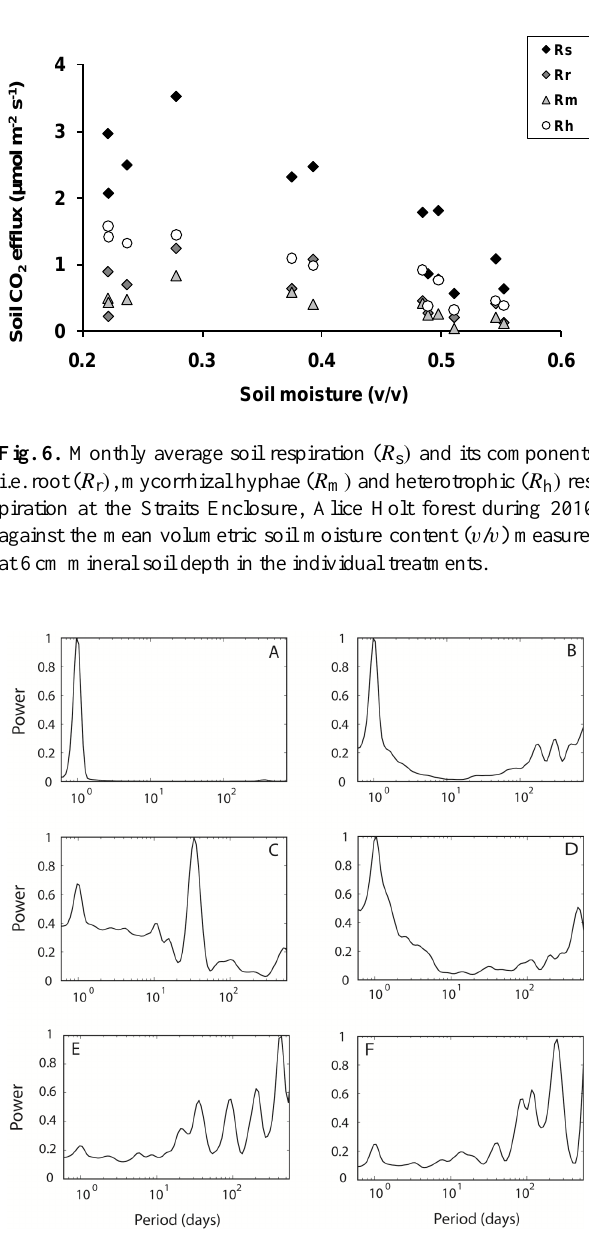
Fig. 7. Global wavelet power spectrum of individual (temperature independent) hourly CO 2 fluxes of GPP (A) , R s (B) , R ab (C) , R r (D) , R h (E) , and R m (F) at the Straits Enclosure, Alice Holt forest from 2007 to 2010. Note that the Nyquist theorem states that only half the length of the time series can be interpreted correctly, thus only 1.5 yr are shown.